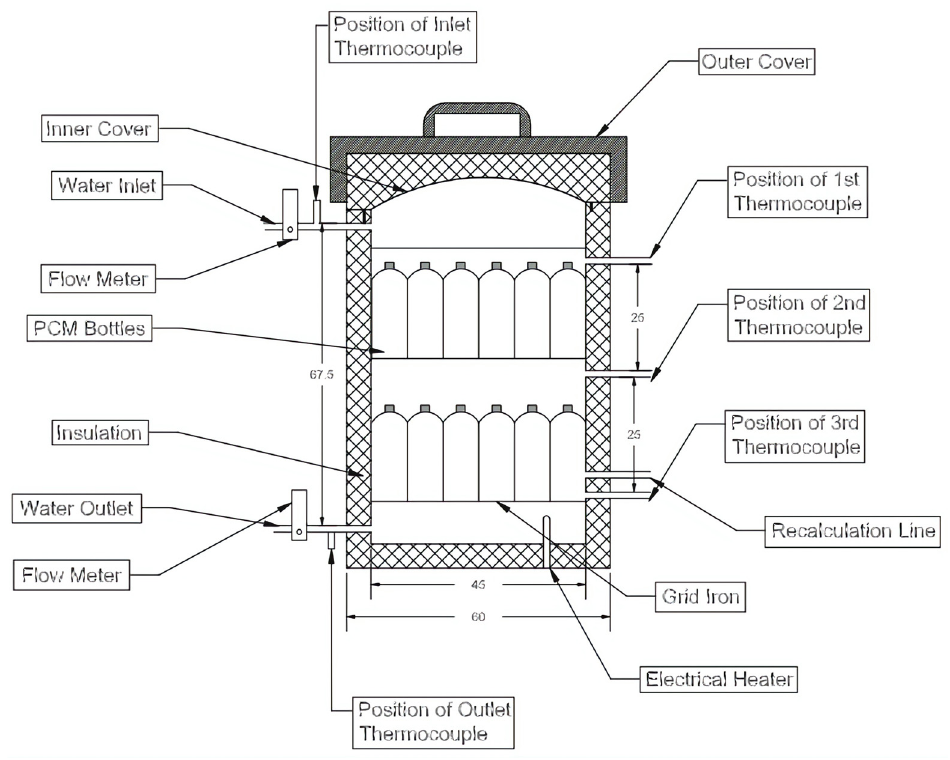
Figure 8. Schematic cross-sectional view of the cylindrical PCM units inside the hot water storage tank [27].